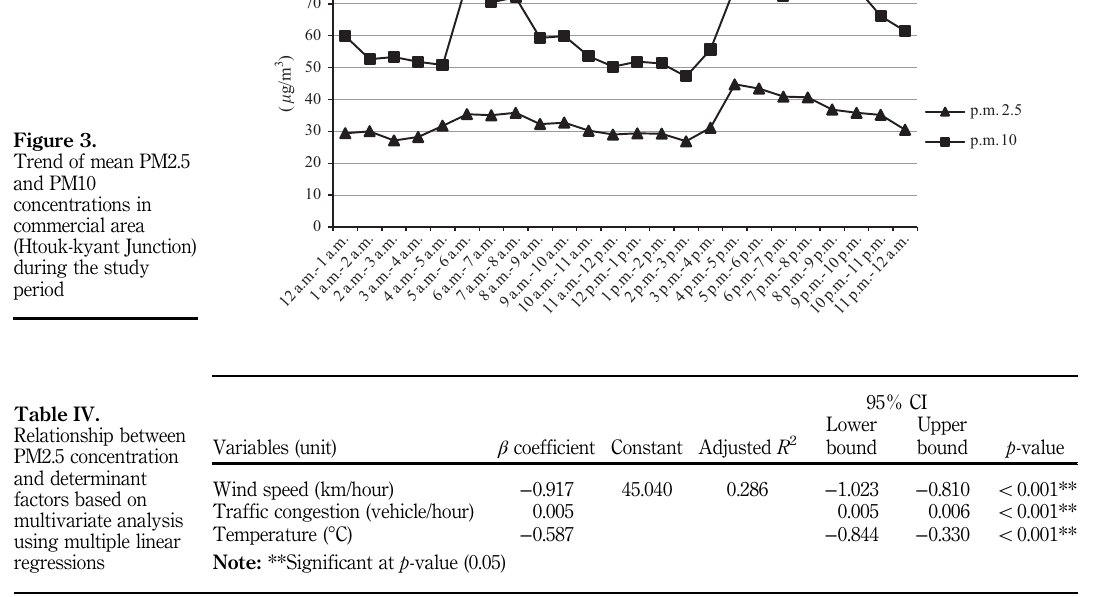
Table IV. Relationship between PM2.5 concentration and determinant factors based on multivariate analysis using multiple linear